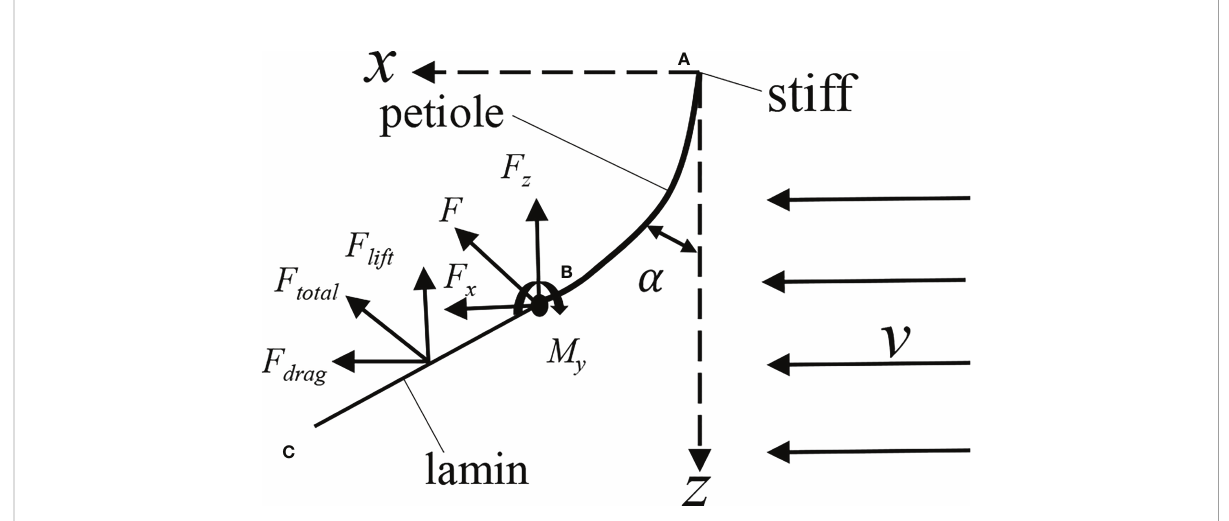
FIGURE 11 Analysis of leaf force. (A) , position of the petiole base; (B) , position of leaf base; (C) , the position of leaf